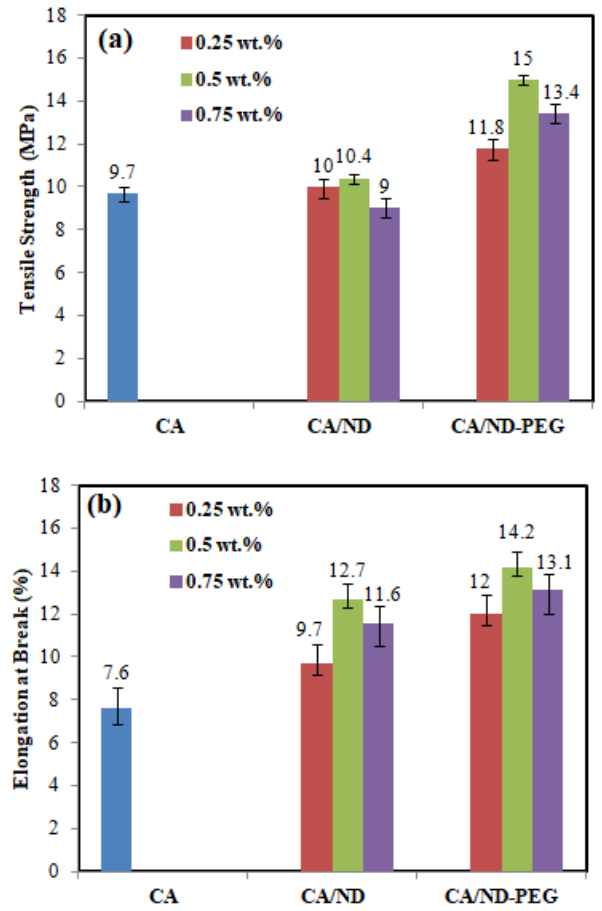
Fig. 5. Mechanical properties of pure and nanocomposite CA membranes; (a) tensile strength and (b) elongation at